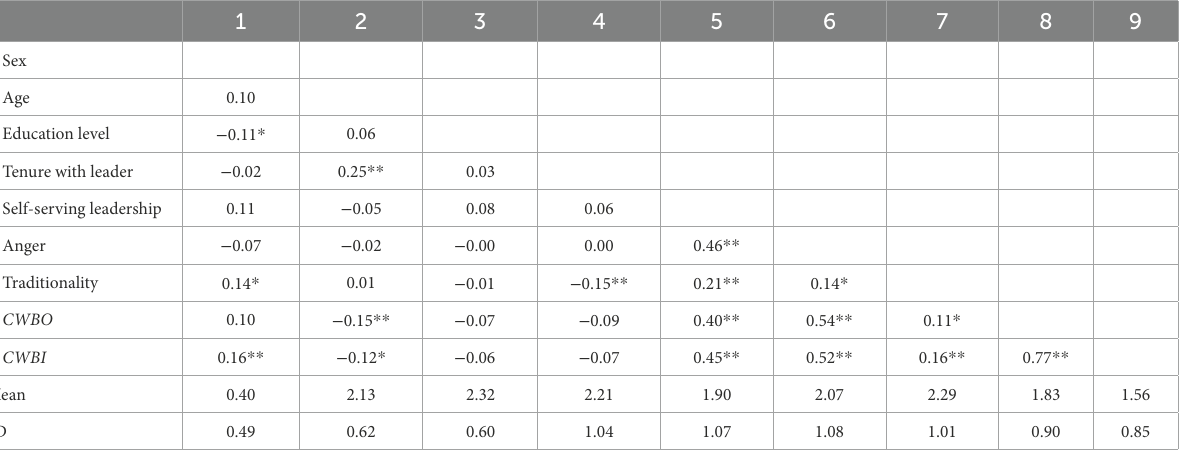
TABLE 2 Results of descriptive statistical